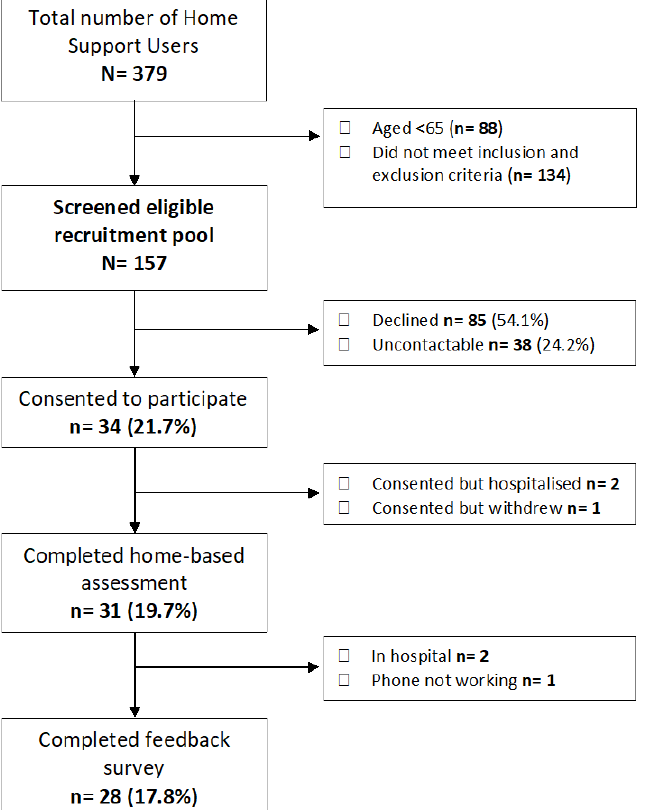
Figure 1. Flow diagram of participants in the home-based assessments and follow-up interviews.